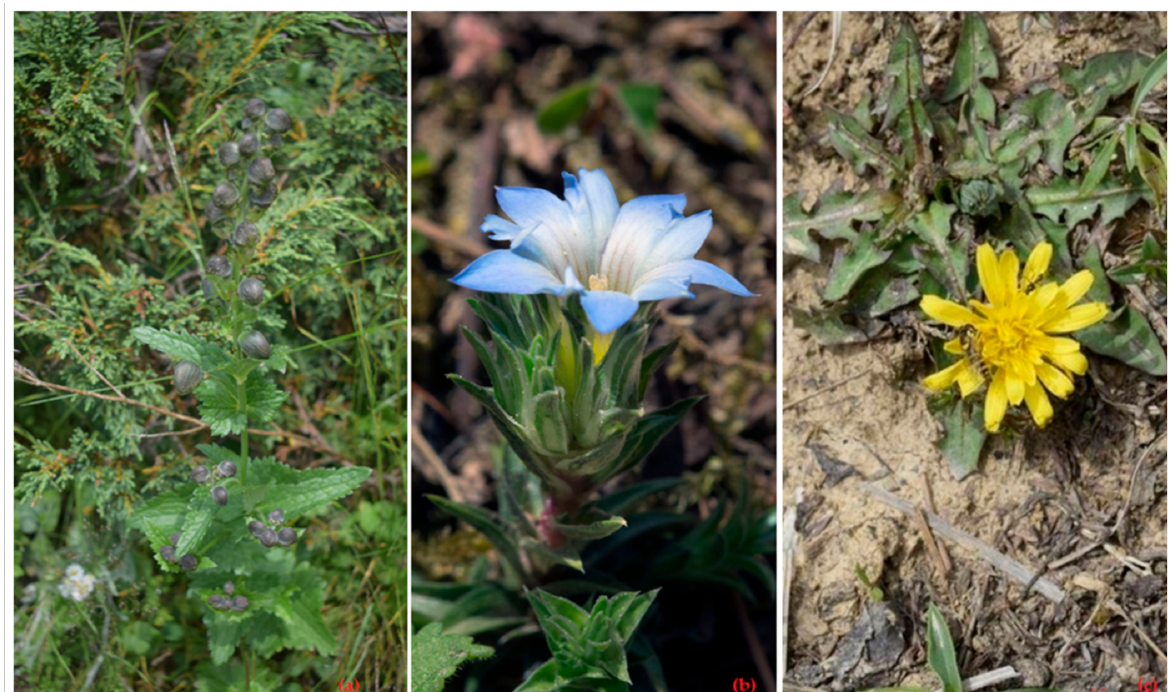
Figure 6. Snapshots of a few of the important high-altitude medicinal plant taxa of the study area ( a ) Aconitum heterophyllum Wall. ex Royle, ( b ) Gentiana argentea (Royle ex D.Don) Royle ex D.Don, ( c ) Taraxacum officinale F.W.